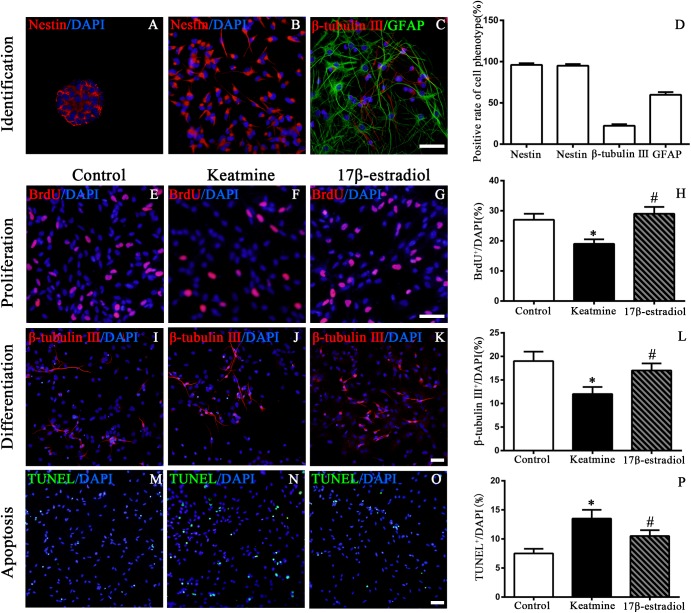
Identification of cultured cells and the proliferation, differentiation as well as apoptosis of NSCs following different treatment. (A) Images of nestin (red) immunoreactive neurosphere. (B) Images of nestin (red) immunoreactive NSCs. (C) Images of NSCs differentiating into neurons (red) and astrocyte (green). Scale bar = 100 μm. (D) Rate of specific cellular phenotype to total cells (DAPI, blue). (E–G) Representative images of BrdU immunoreactive cells (red) in control, ketamine, and 17β-estradiol group, respectively. Scale bar = 100 μm. (H) Quantification of BrdU-positive cells following different treatment. ∗p < 0.05 compared with control group, #p < 0.05 compared with ketamine group. (I–K) Representative images of β-tubulinimmunoreactive cells (red) in control, ketamine, and 17β-estradiol group, respectively. Scale bar = 50 μm. (L) Quantification of β-tubulin III -positive cells following different treatment. ∗p < 0.05 compared with control group, #p < 0.05 compared with ketamine group. (M–O) Representative images of TUNEL immunoreactive cells (green) in control, ketamine, and 17β-estradiol groups, respectively. Scale bar = 50 μm. (P) Quantification of TUNEL-positive cells following different treatment. ∗p < 0.05 compared with control group, #p < 0.05 compared with ketamine group. Data were collected from three independent experiments and are presented as the means ± SEM.